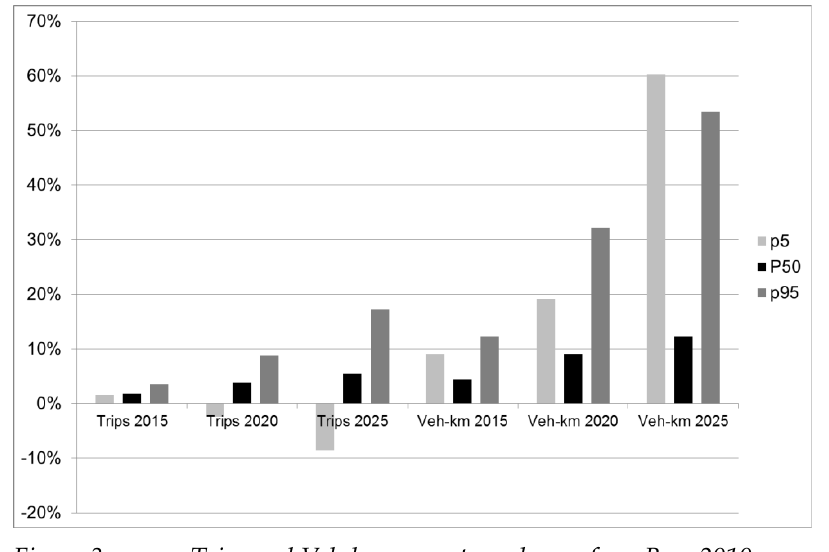
Figure 3. Trips and Veh-km percentage change from Base 2010